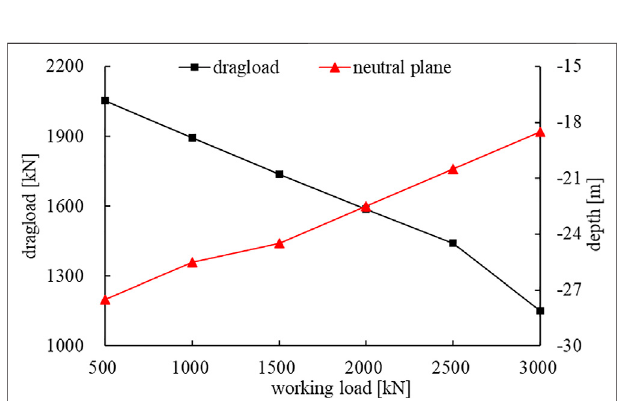
FIGURE 11 | Development of dragload and neutral plane with an increase of the working load.